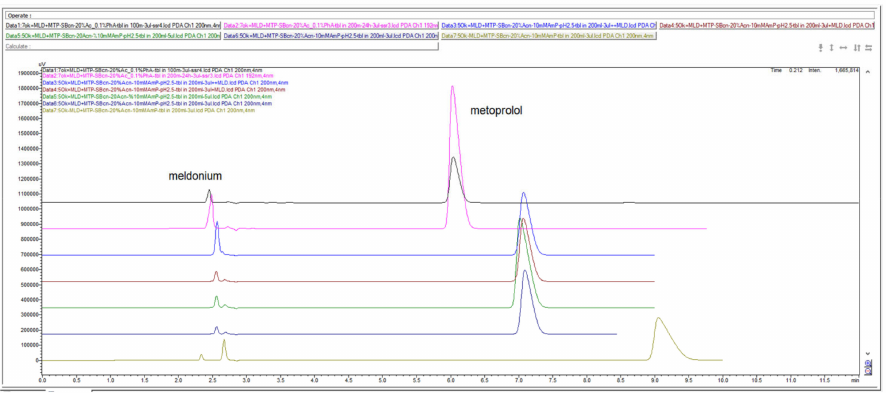
Figure 48. Chromatograms created with 20% ACN and 80% o-H 3 PO 4 (the top 2 chromatograms), with acidified 13 mM NH 4 H 2 PO 4 to pH = 2.5 (medial 4 chromatograms) and with untreated 13.3 mM NH 4 H 2 PO 4 . High acidity of eluents showed higher peaks asymmetries of some peak.